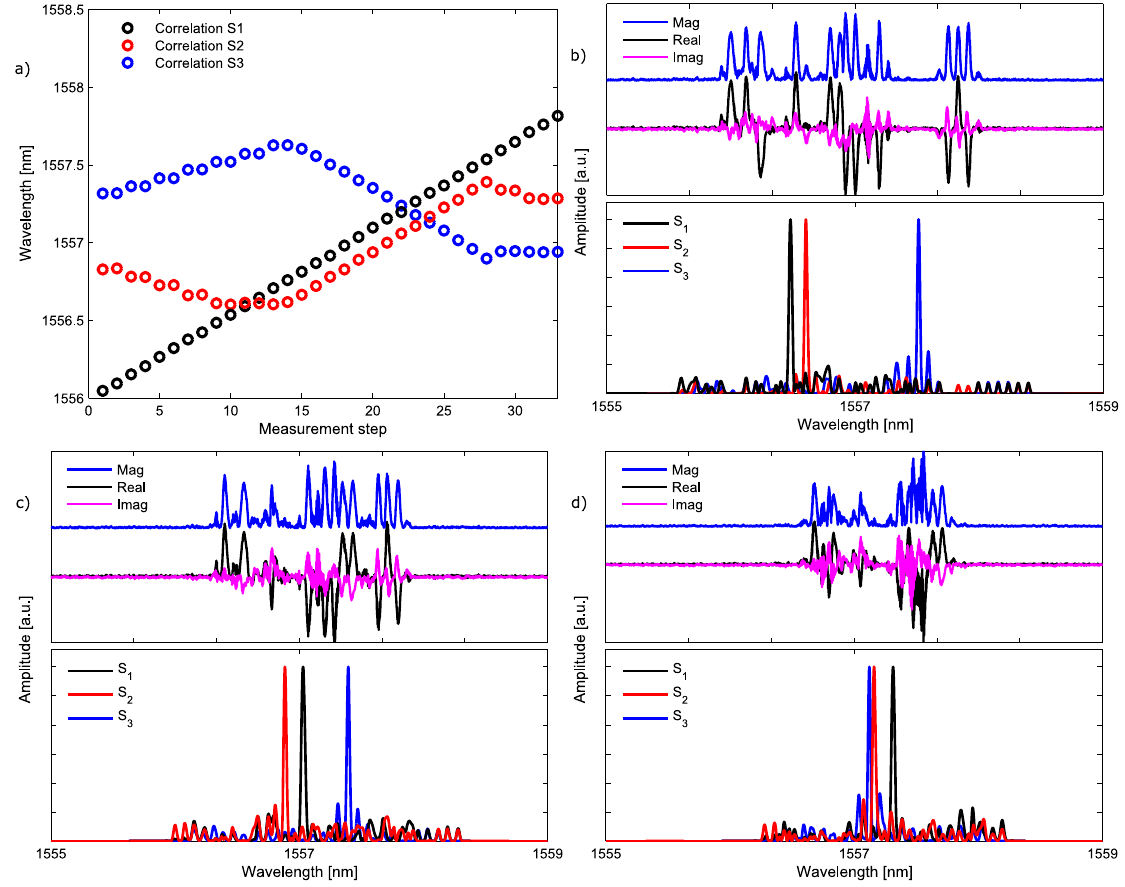
Figure 9. Each sensor’s central wavelength is depicted for the whole overlapping scenario between the three sensors in ( a ). ( b – d ) Three intermediate captures of the system; the upper plot depicts the sensing network readout (magnitude, real and imaginary components) while the lower plot presents the retrieved central wavelength obtained for each sensor after running the correlation